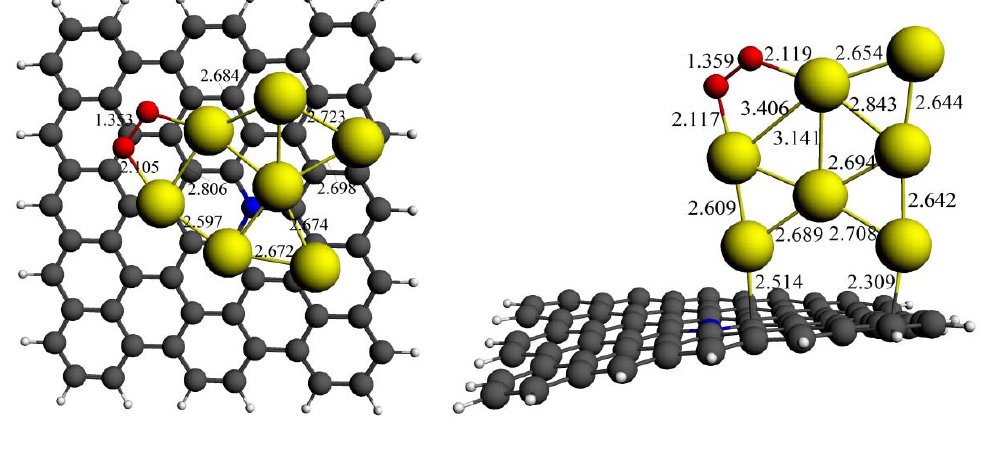
Figure 5. Optimized structures of the O cluster with bridge mode (distances are in